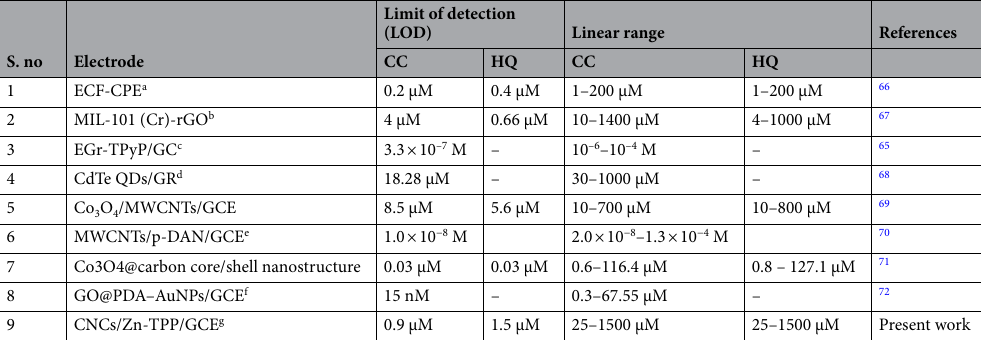
Table 1. Comparison of performance of CNCs/Zn-TPP/GCE for catechol (CC) and hydroquinone (HQ). a ECF-CPE: Electrospun Carbon Nanofiber-Carbon paste electrode. b MIL-101 (Cr)-rGO: Metal organic framework-reduced graphene oxide. c EGr-TPyP/GC: Electrochemically exfoliated graphene- tetrapyridylporphyrin/Glassy carbon electrode. d CdTe QDs/GR: Cadmium Telluride Quantum dots/Graphene. e MWCNTs/p-DAN/GCE: Multi-walled carbon nanotubes/poly(1,5-diaminonaphthalene) composite